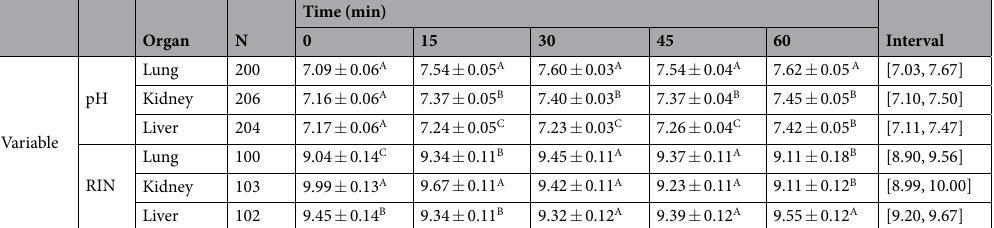
Supplementary Table S1. A pH significant increase according to time (third-order polynomial model) was found in mice for liver, kidney and lung (Table 1). Fisher’s least significant difference remained unchanged at time-zero (Fig. 1). Following the ischemic insult, time dependence was always higher in lung, followed by kidney and liver, with a pH range of 0.64, 0.4 and 0.36, respectively. Although RIN’s statistical power did fit a second-order time evolution (Supplementary Fig. S5), in biological terms, this result does not modify its clinical use. In this study, the adjusted RIN was greater than 8.90, with the minimum acceptance threshold being RIN = 7. On the other